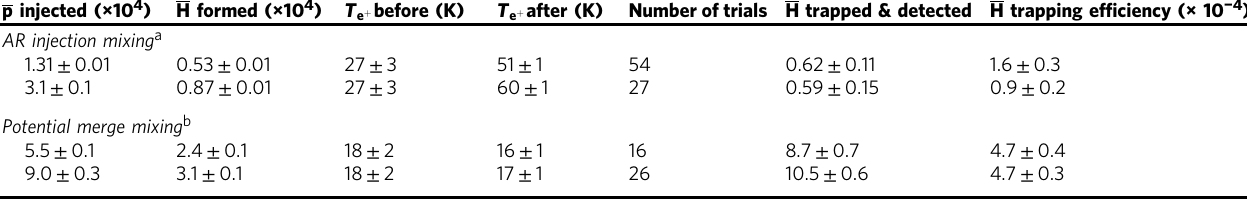
Table 1 Figures of merit characterising antihydrogen formation and trapping ef fi ciencies p injected (×10 4 )